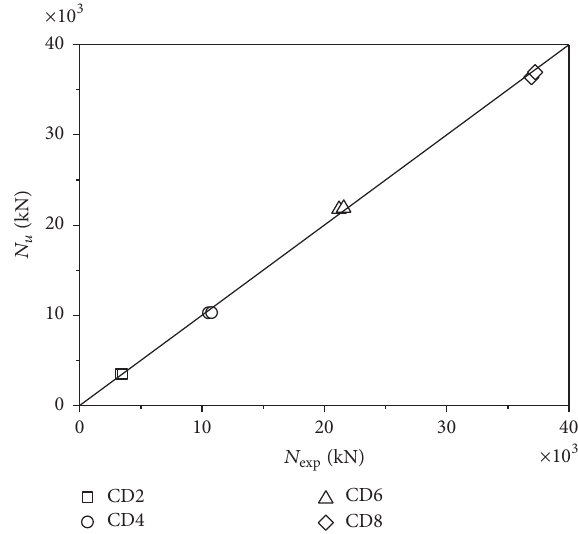
Figure 11: 𝐾 - 𝑓 𝑟 /𝑓 𝑐𝐷 relationship at moment of peak load.